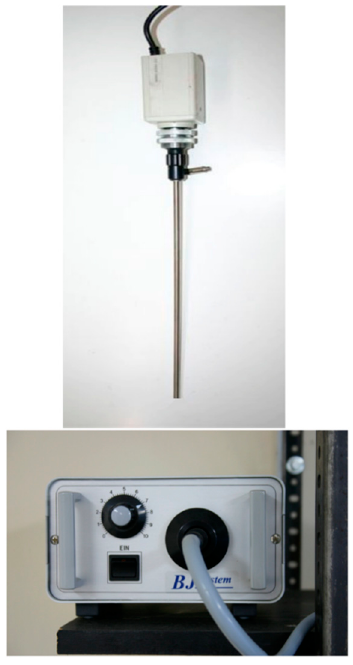
Figure 6. Stiff endoscope. Figure 6. Sti ff